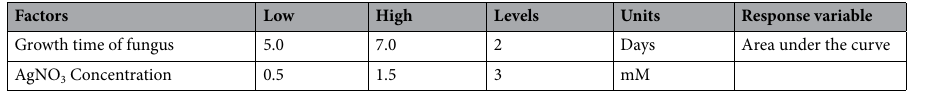
Table 1. Attributes of factorial design multilevel CS samples of the fungus anamorphous Bjerkandera sp. R1.